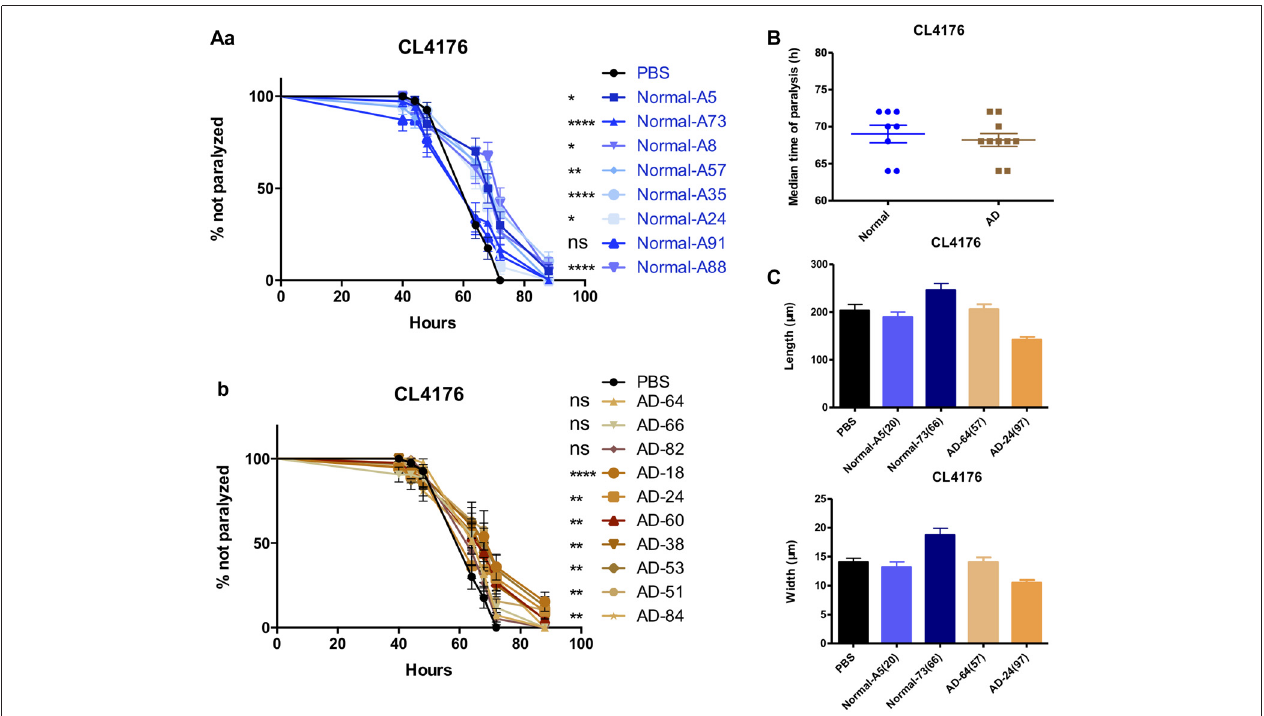
FIGURE 6 | The effects of serums from normal subjects and AD patients on the paralysis in CL4176. (A) The effects of serum from normal subjects (a) and AD patients (b) in CL4176 worms. (B) Comparable median time of paralysis in CL4176 worms by feeding serum from normal subjects and AD patients. (C) No growth-promoting effects by feeding serum. Paralysis data were analyzed using a paired log rank survival test. Median time of paralysis was analyzed with two-tailed unpaired Student’s t -test. Body size was analyzed with One-way ANOVA, Tukey’s multiple comparisons post hoc . ∗ P < 0.05; ∗∗ P < 0.001; ∗∗∗∗ P < 0.0001, ns: P > 0.05, no significant